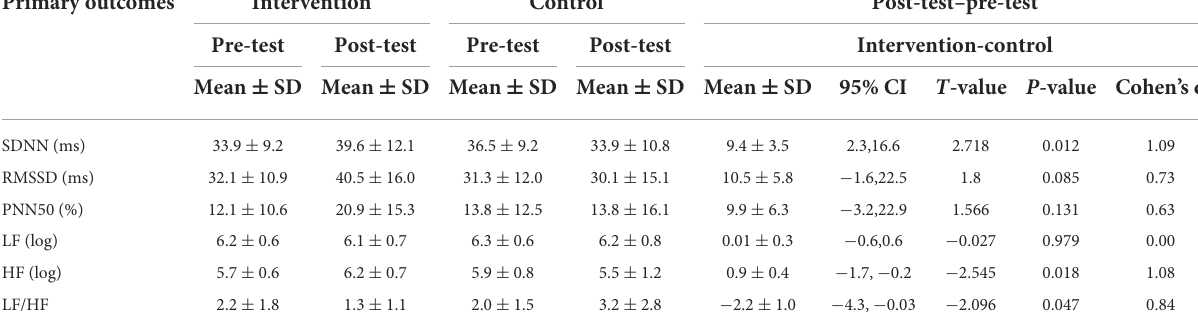
TABLE 3 Differences of mean HRV indices compared with the control group.